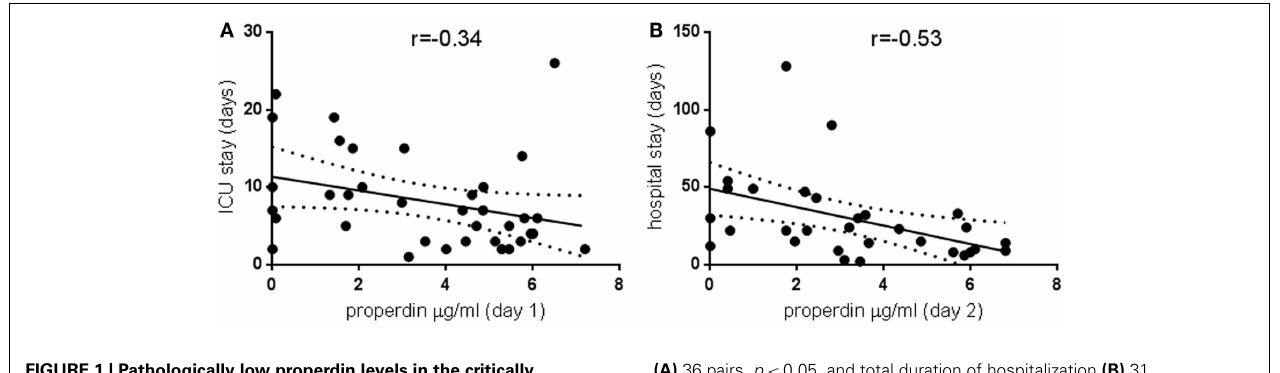
FIGURE 1 | Pathologically low properdin levels in the critically ill and the relationship to treatment duration . Properdin levels lower than 7 µ g/ml, the lowest of the normal range established in this study, were plotted against duration of intensive care treatment